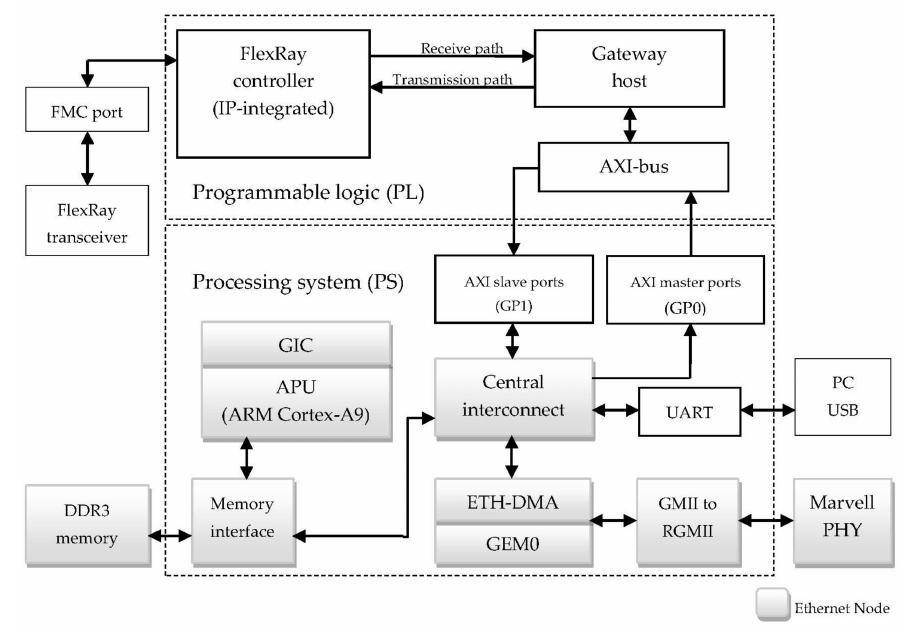
Figure 5. The design of proposed gateway system based on Zynq-7000 AP SoC. The Ethernet node is implemented by both PS and